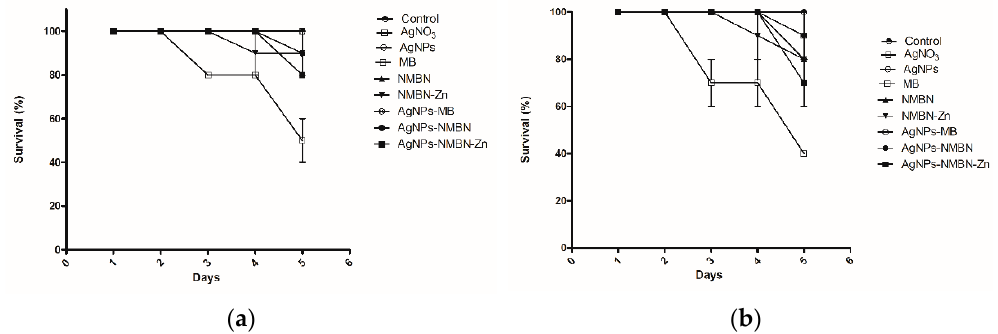
Figure 6. Toxicity of APDT in G. mellonella larvae. Larvae were inoculated with the compounds AgNO 3 , AgNPs, MB, NMBN, NMBN-Zn, and associations. The concentration of each compound injected in G. mellonella larvae is shown in Table 5, group of the larvae number 5. ( a ) Survival of G. mellonella larvae over the days in the dark; ( b ) survival of G. mellonella larvae over the days after APDT 15 J cm − 2 . Control, naïve and PBS; AgNO 3 , silver nitrate; AgNPs, silver nanoparticles; MB, methylene blue; NMBN, new methylene blue N; NMBN-Zn, new methylene blue N Zinc; associations AgNPs-MB, AgNPs-NMBN, and AgNPs-NMBN-Zn.